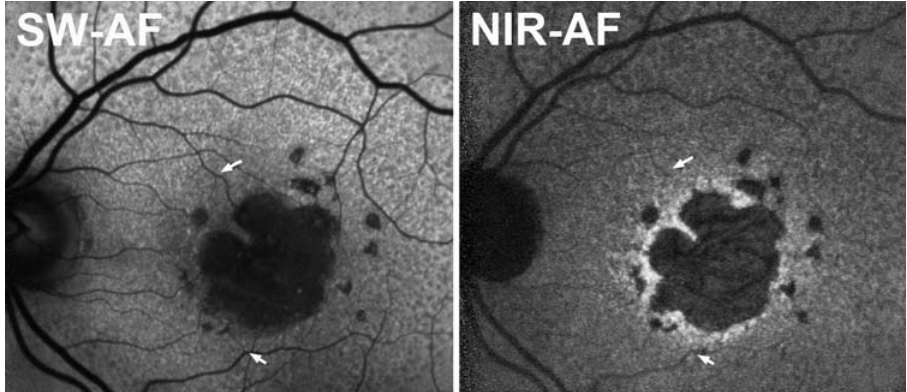
Figure 7. An area of geographic atrophy (GA) imaged with short-wavelength (SW) and near-infrared (NIR) autofluorescence (AF) imaging. GA appears dark with both modalities. The zone surrounding GA is hyperautofluorescent in the NIR-AF image while having relatively normal SW-AF signal. When vessel landmarks are used as a guide (arrows), total lesion size appears larger in the NIR-AF image.